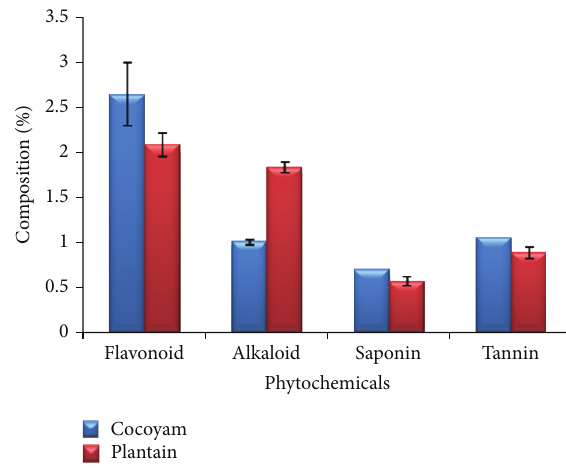
Figure 2: Phytochemical composition of cocoyam and unripe plantain incorporated